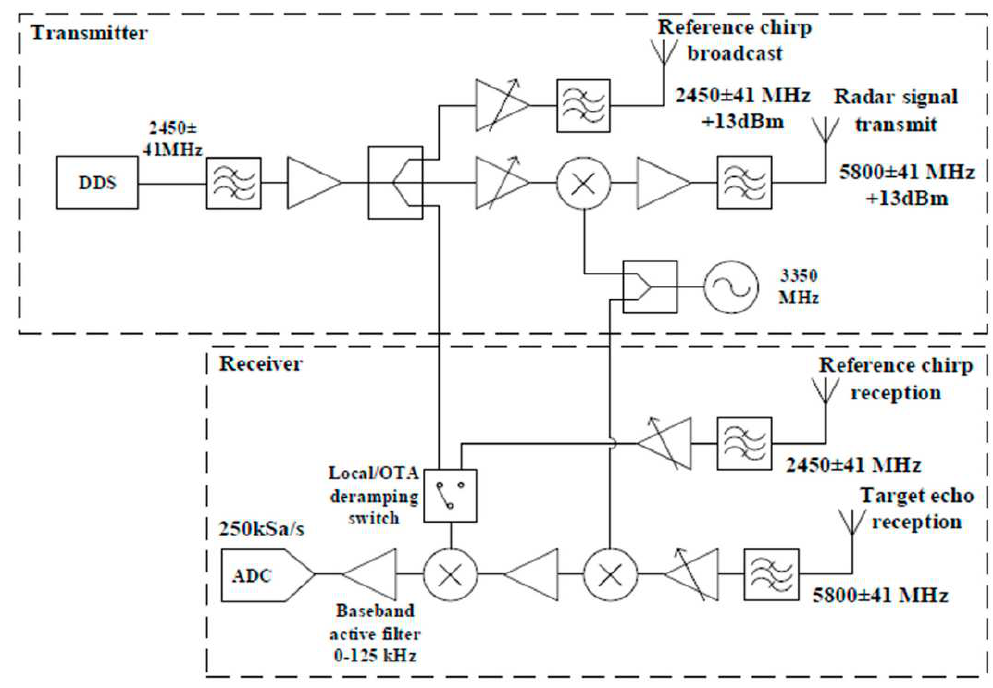
Figure 10. Topology of the FMCW radar used to detect humans through a wall [121].